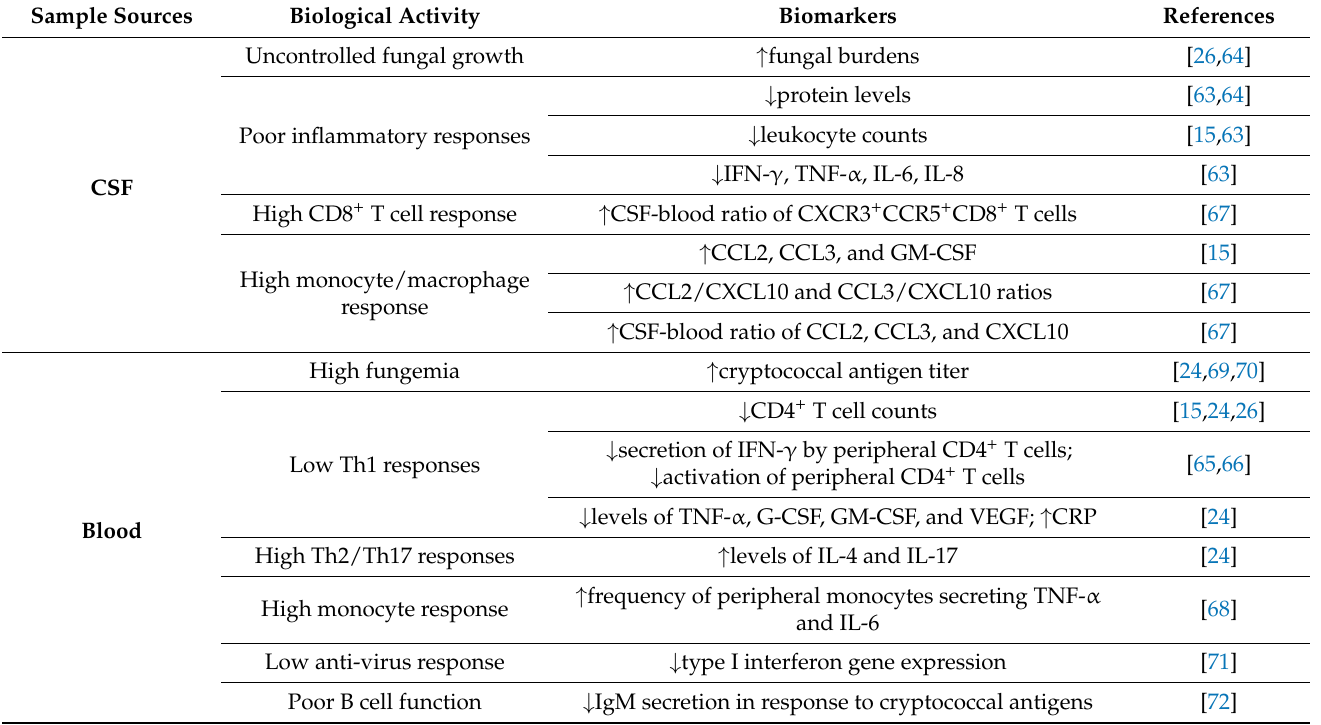
Table 1. Biomarkers predictive of cryptococcal IRIS in HIV-infected patients prior to ART. Sample